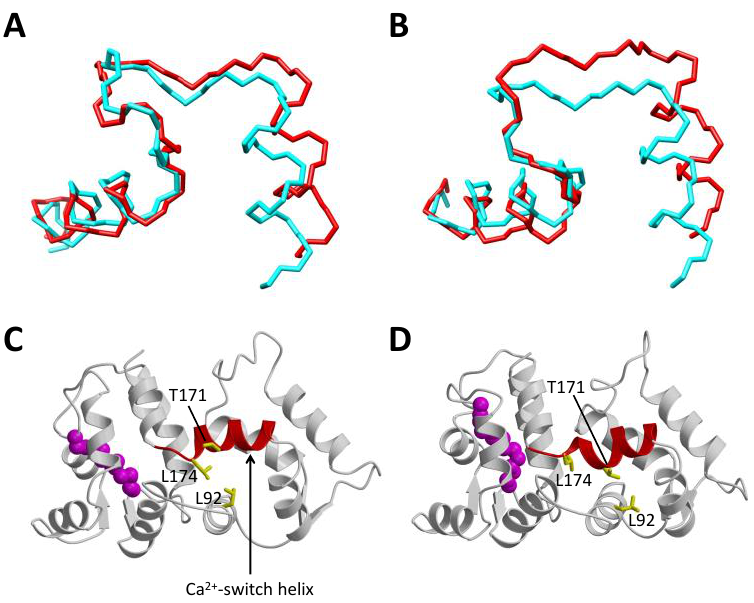
Figure 3. Ca 2+ -induced conformational changes in GCAP1. Main chain structures of EF2 ( A ), EF3 ( B ), Mg 2+ -bound/Ca 2+ -free GCAP1 V77E ( C ), and Ca 2+ -bound GCAP1 ( D ). The Ca 2+ -free structures of EF2 and EF3 (red in panels ( A , B )) are overlaid on top of the Ca 2+ -bound structures (cyan). EF2 and EF3 exhibit a Ca 2+ -induced decrease in interhelical angle. The Ca 2+ -switch helix (residues 169–174) undergoes a Ca 2+ -induced shortening (highlighted red in panels ( C , D )).